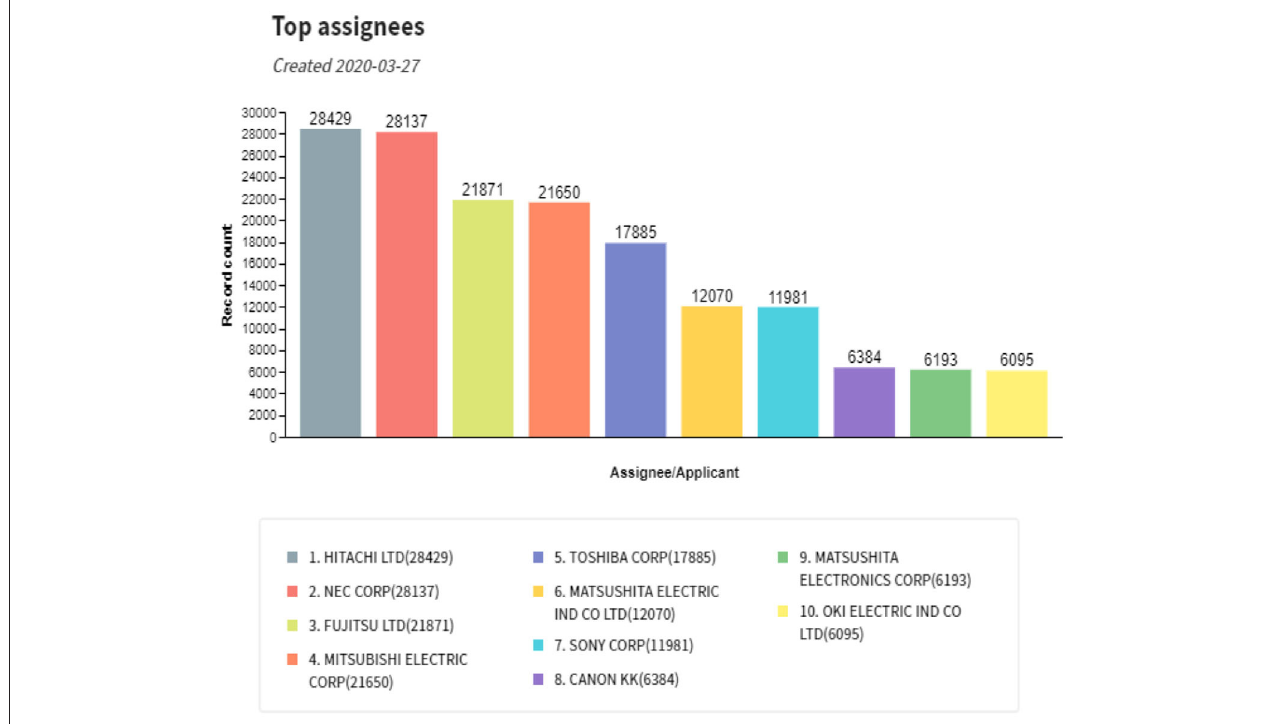
FIGURE 1 | Top international assignees for semiconductor patents during the 1980s and 1990s. Note that all the top ten assignees were Japanese